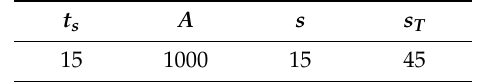
Table 3. Experimental value of s T for each of the seven beacons.